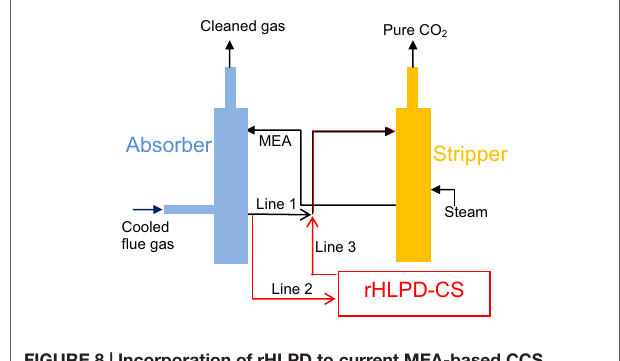
FigUre 8 | incorporation of rhlPD to current Mea-based ccs technology . Black lines represent current process, and red lines represent modifications utilizing rHLPD